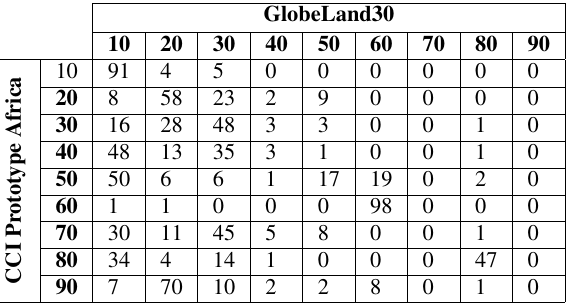
Table 5. Row-wise normalized confusion matrix [%].